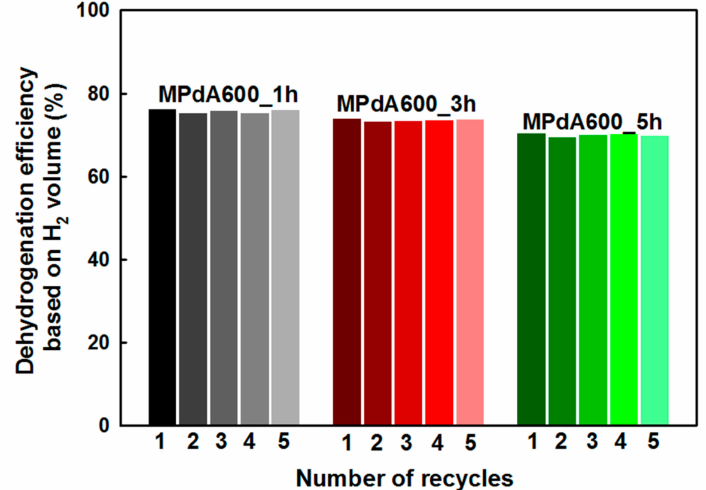
Figure 12. Recyclability of the MPdA catalysts calcined at 600 ◦ C for di ff erent periods in the dehydrogenation of H 12 -MBP at M / R of 0.1 mol% and 250 ◦ C for 4